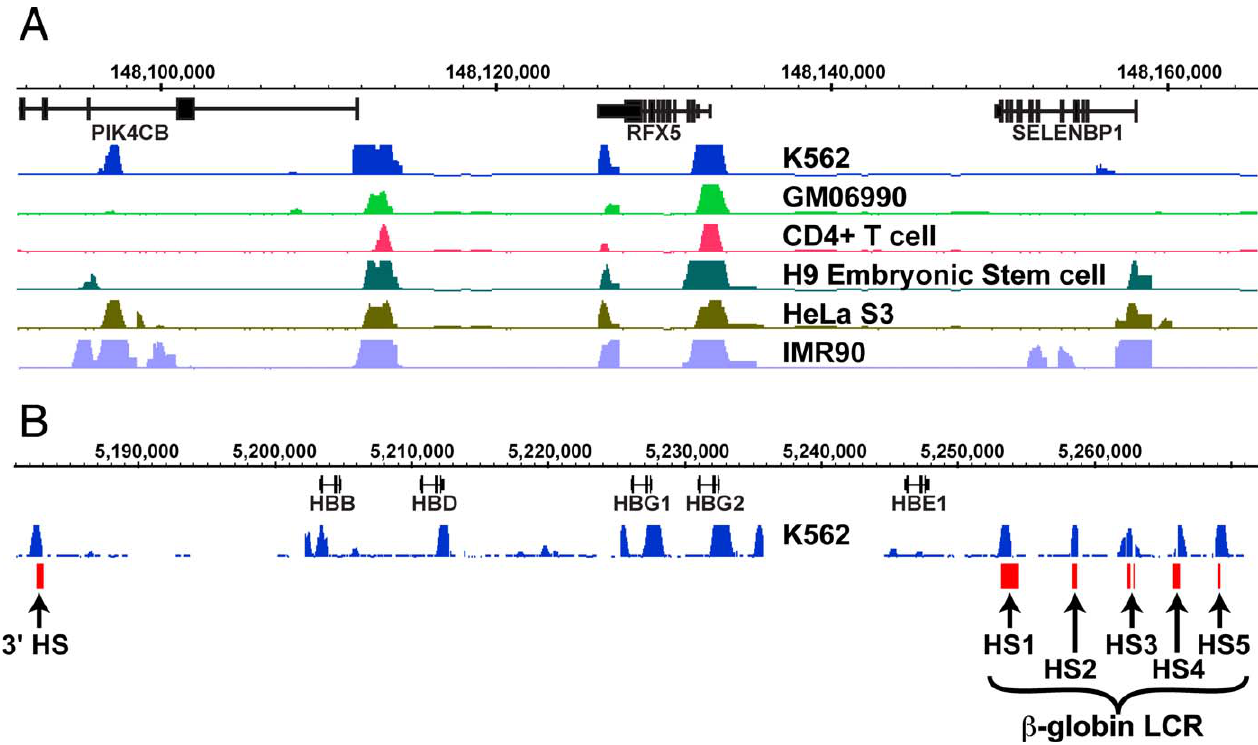
Figure 1. Identification of DNaseI HS Sites from Six Cell Types (A) Representative DNase-chip data from ENCODE region ENr231 (Chr1:148050000–148165000). Note that there are common, ubiquitous, and cell type– specific DNaseI HS sites. (B) DNase-chip from K562 cells identifies all five LCR DNaseI HS sites upstream of the b -globin locus, as well as the 3 9 DNaseI HS site (in red). There are additional DNaseI HS sites identified around promoter regions of the globin